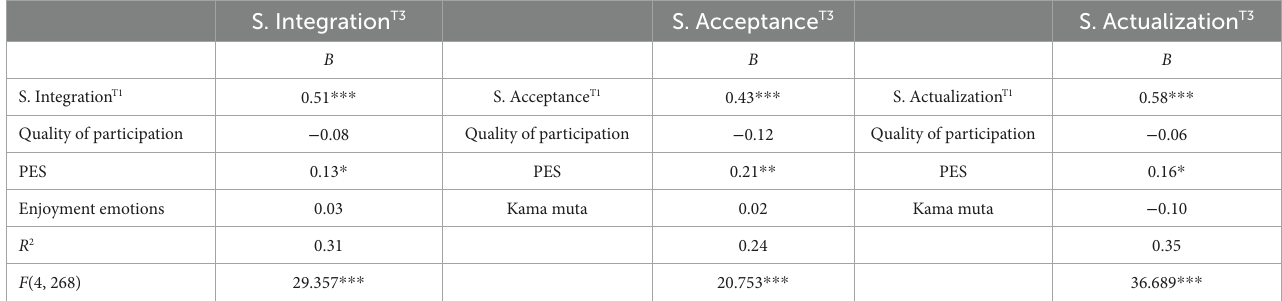
TABLE 2 Multiple linear regressions of the effect of the quality of participation, of perceived emotional synchrony and of proximal effects on social integration, social acceptance and social actualization on T3, controlling for T1